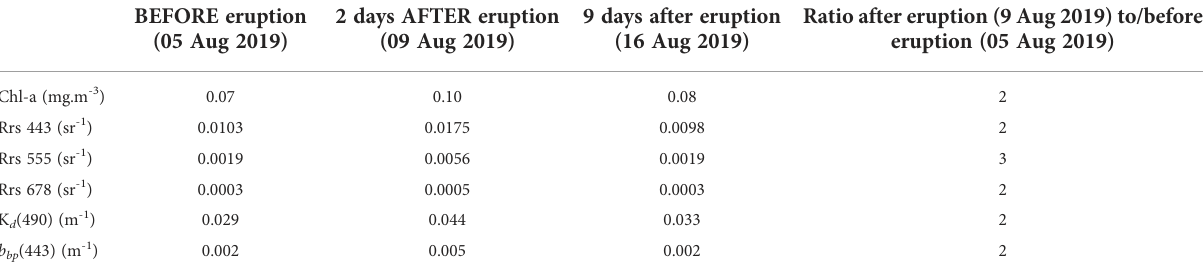
All spectral and IOP data in this table were obtained from MODIS